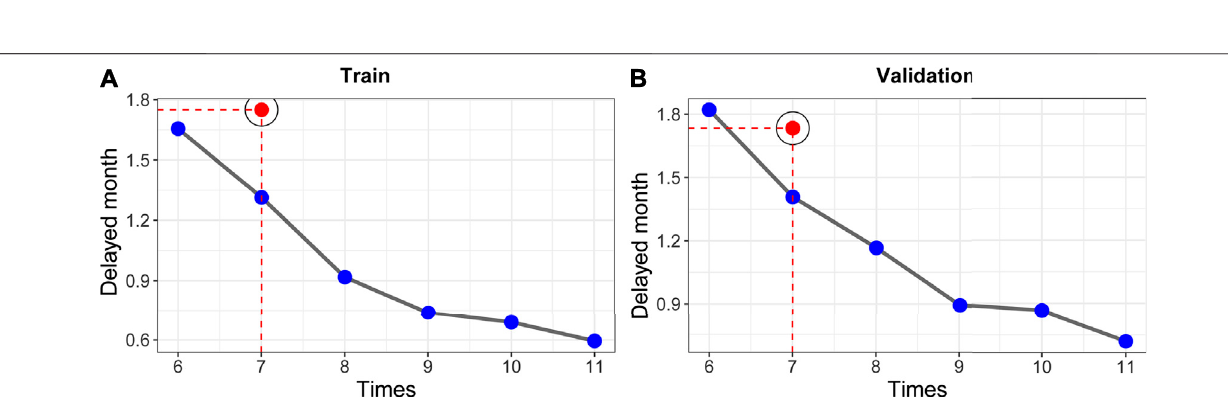
Frontiers in Bioengineering and Biotechnology |